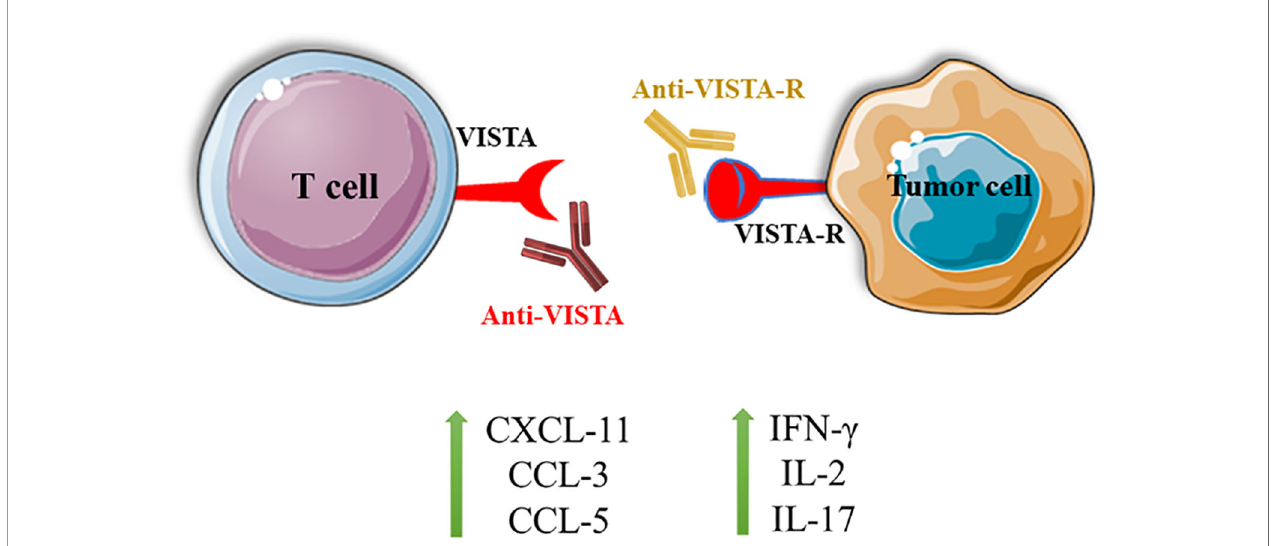
FIGURE 1 | Blocking the interaction between VISTA and VISTA-R can lead to T cell activation and the upregulation of IFN- g , IL-2, IL-17, CXCL-11, CCL-3, and CCL-5. VISTA, V-domain Ig suppressor of T cell activation; VISTA-R,